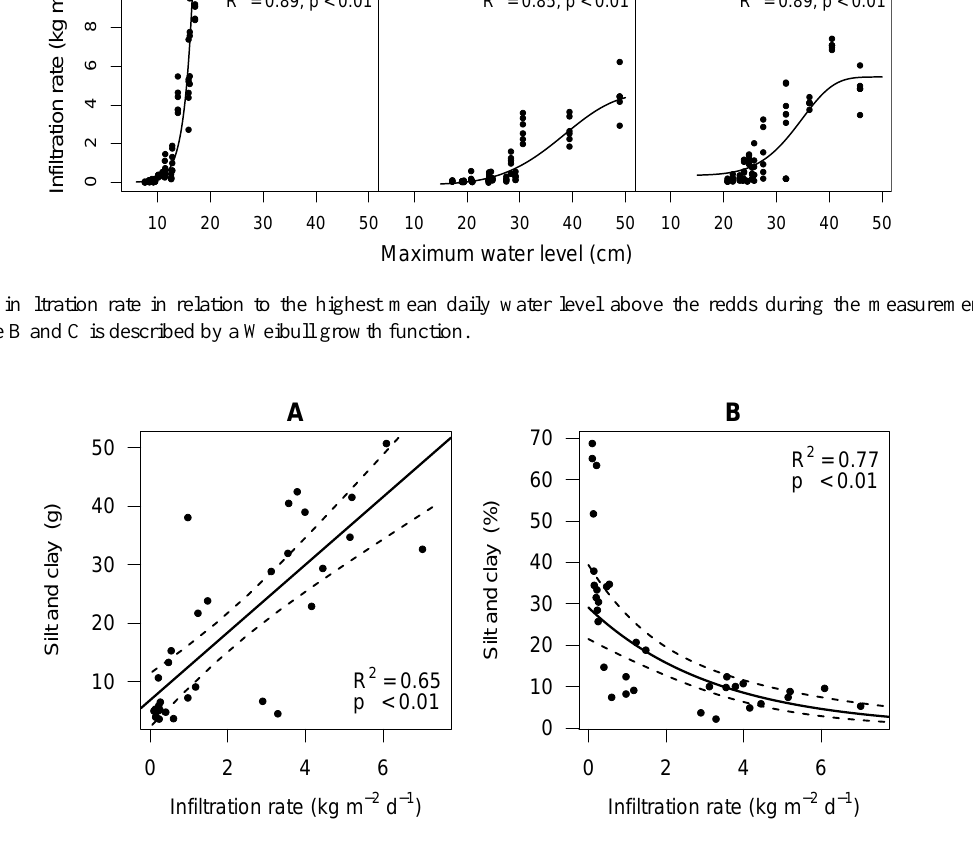
Fig. 7. Weekly silt and clay infiltration at site C in absolute values (A) and relative values (i.e., fraction of silt and clay of the total fine sediment deposition; (B) ) in relation to the daily infiltration rate of sediment < 2mm. Dashed lines are the 95% confidence